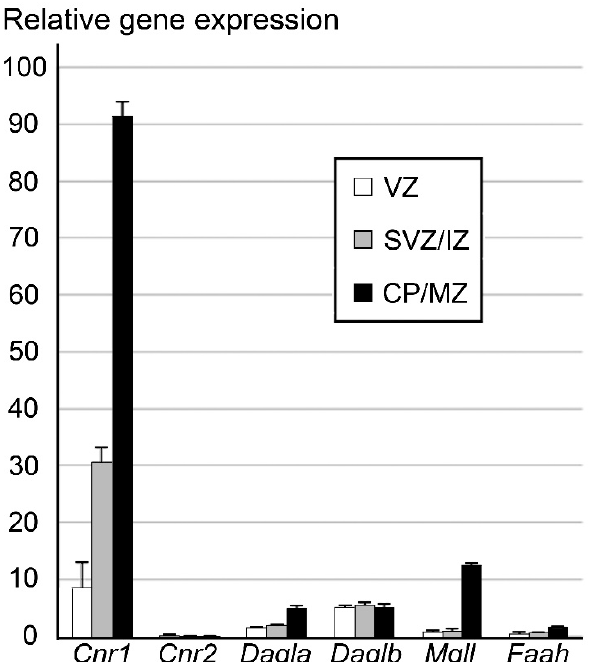
Figure 1. Quantitative whole-transcriptome mRNA sequencing data of the endocannabinoid system genes in the cortical zones from the embryonic day (E) 14.5 mouse embryo. X axis shows endocannabinoid system genes: Cnr1 and Cnr2 cannabinoid type 1 and type 2 receptors, respectively; endocannabinoid synthesizing enzymes Dagla and Daglb , sn-1-specific diacylglycerol lipase alpha and beta, respectively; endocannabinoid metabolizing enzymes Mgll and Faah , monoacylglycerol lipase and fatty acid amide hydrolase, respectively. Y axis shows the abundance of the genes by calculating reads per kilobase of the exon model per million mapped reads; average ± SEM from 3 embryos analyzed [33]. Notice dramatic upregulation of CB 1 R gene expression in parallel with neuronal maturation and relocation from VZ to CP. Expression of other genes of the endocannabinoid system is low if any in all analyzed embryonic cerebral zones making doubt for the capacity of immature cells to synthesize endocannabinoids. Increase of endocannabinoid degrading enzyme Mgll in CP / MZ may be due to its expression in the interneurons tangentially migrating through MZ or projection neurons settling in CP.